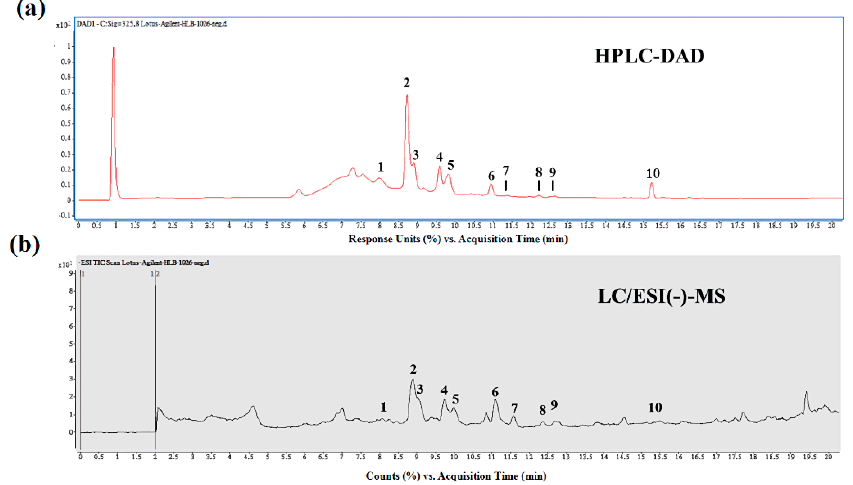
Figure 1. Component identification of lotus seedpod aqueous extracts (LSE). HPLC-DAD (high-performance liquid chromatography-diode array detector) chromatogram at 325 nm ( a ) and LC–ESI ( − )-MS total ion current chromatogram ( b ) of LSE. The peak numbers, including peaks 1. myricetin-3-galactoside, 2. quercetin-3-glucuronide, 3. isoquercitrin, 4. isoquercitrin, 5. isorhamnetin-3-glucoside, 6. unknown, 7. quercetin, 8. kaempferol, 9. isorhamnetin, and 10. unknown, are referred to in Table 1.